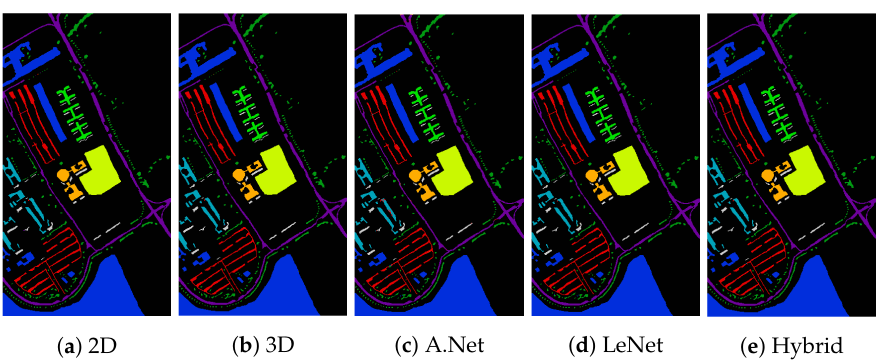
Figure 3. Pavia University: Classification accuracy: ( a ) 2D-CNN = 99.9070%; ( b ) 3D CNN = 99.9256%; ( c ) AlexNet = 99.0768%; ( d ) LeNet = 99.9318%; and ( e ) Hybrid =